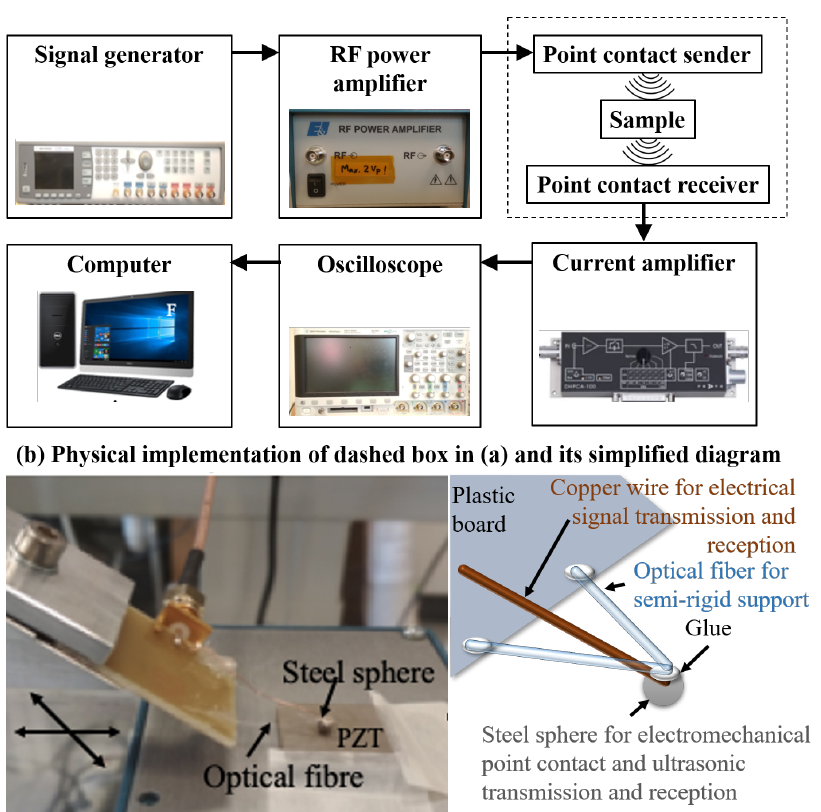
Figure 1. Experimental setup for point contact excitation and detection in piezoelectric (PZT) ceramics. ( a ) Block diagram of the setup. ( b ) The steel sphere works as the sender and receiver, the V-shaped structure of the optical fiber works as semi-rigid support for the steel sphere, and the PZT is the sample which may be damaged.